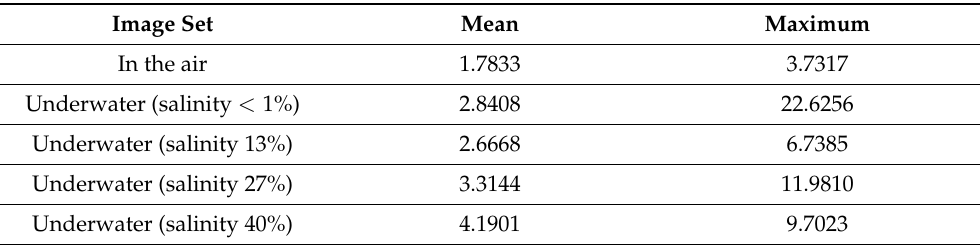
Table 3. Accuracy evaluation of chessboard cell corner detection using the OpenCV library find- ChessboardCorners